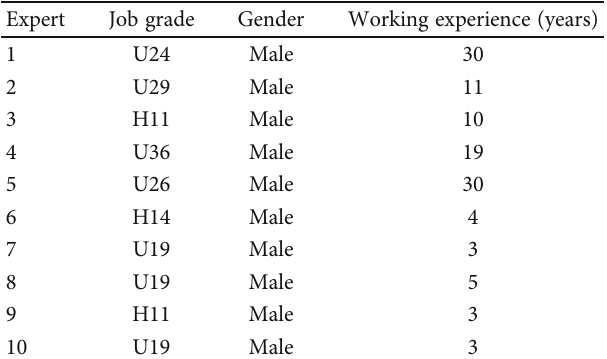
Table 2: Characteristics of